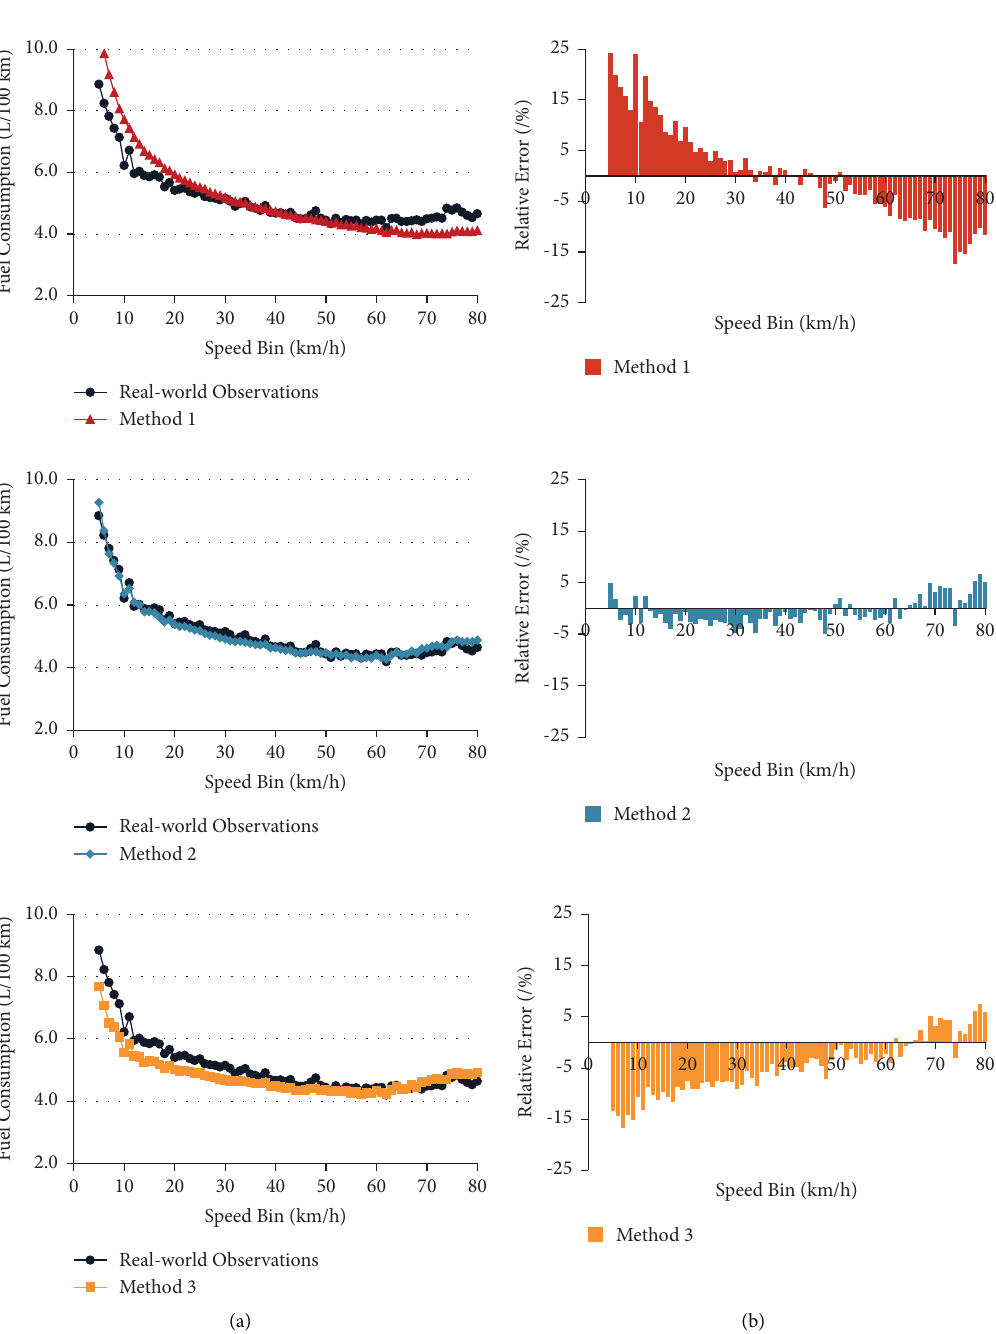
Figure 10: Comparison of validation and error in three methods. (a) Fuel consumption in speed bin, (b) relative error in speed